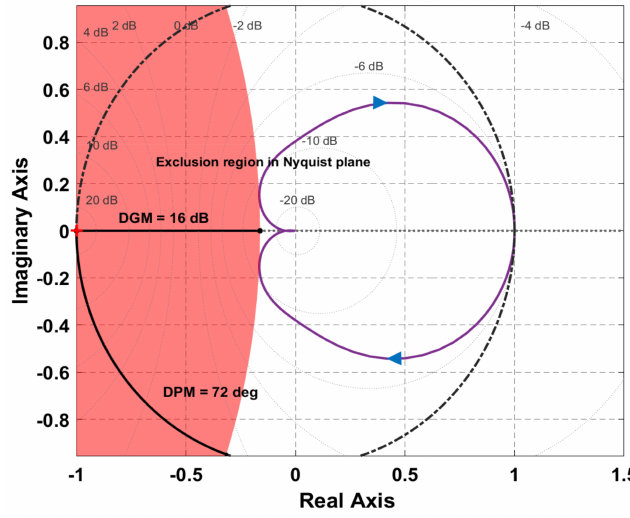
Figure 5. The disk margin of the fourth case